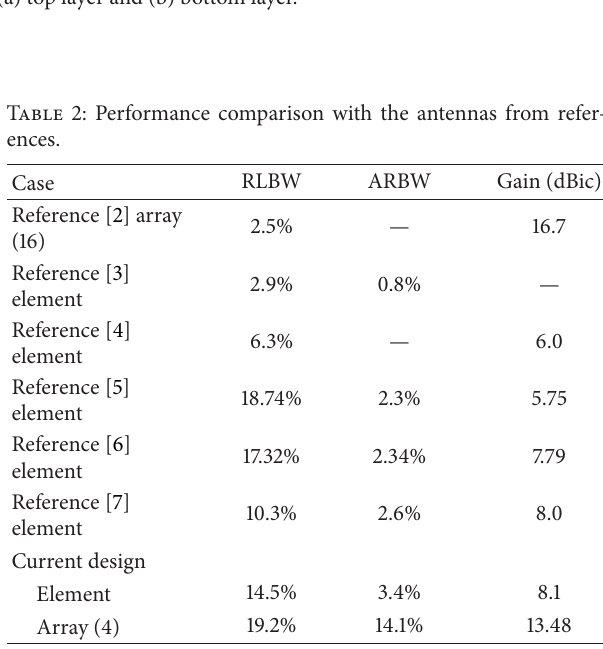
Figure 7: Fabricated antenna array: (a) top layer and (b) bottom layer.